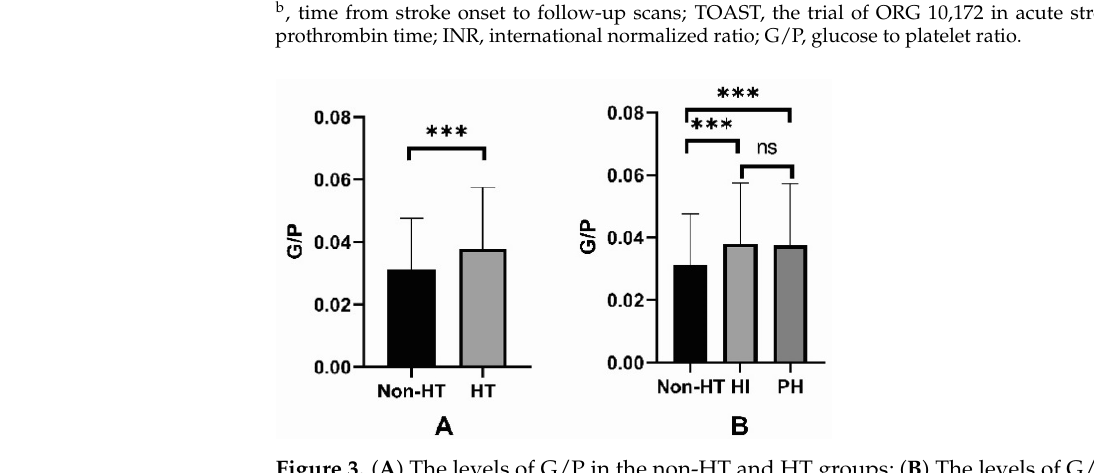
Figure 3. ( A ) The levels of G/P in the non-HT and HT groups; ( B ) The levels of G/P in the non-HT, HI, and PH groups. G/P, glucose to platelet ratio; HT, hemorrhagic transformation; HI, hemorrhagic infarction; PH, parenchymal hemorrhage. The ns stands for not statistically significant. *** p < 0.001. Table 2. Characteristics of patients with HI or with PH.